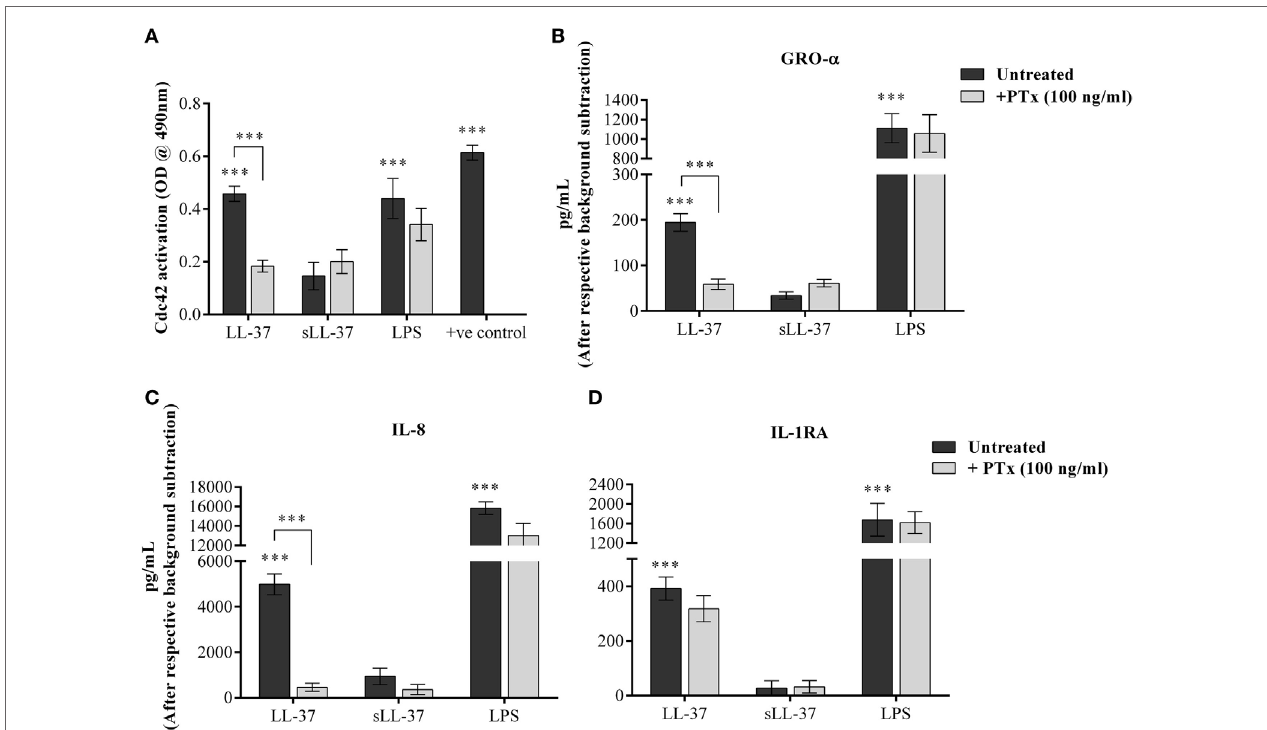
FigUre 9 | LL-37-induced activation of Cdc42/Rac1 Rho GTPase and chemokine secretion is mediated through G protein-coupled receptor (GPCR). Macrophage- like THP-1 cells were treated 100 ng/ml of the GPCR inhibitor pertussis toxin for 1 h, prior to stimulation with either LL-37 (5 µM), sLL-37 (5 µM each), or lipopolysaccharide (10 ng/ml). (a) Cells lysates were monitored for Cdc42 activation after 5 min of stimulation. Results shown as mean ± SE of five independent experiments ( n = 5). Tissue culture supernatants were monitored by ELISA for the production of chemokines (B) GRO- α and (c) IL-8 after 24 h, and (D) anti- inflammatory cytokine IL-1RA after 48 h. ELISA results shown are mean ± SE of six independent experiments ( n = 6). Analysis of variance with Bonferroni’s post hoc test was used for statistical analyses (*** p <